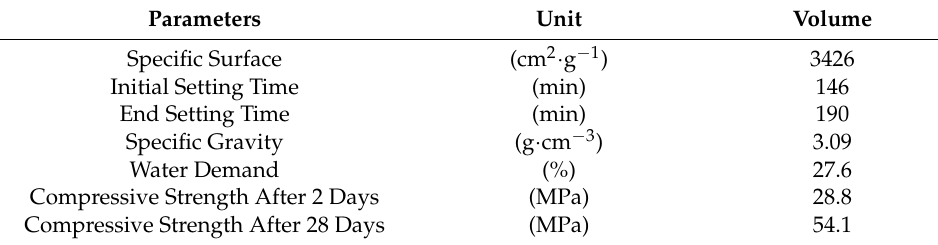
Table 3. Properties of CEM I 42.5R [41].